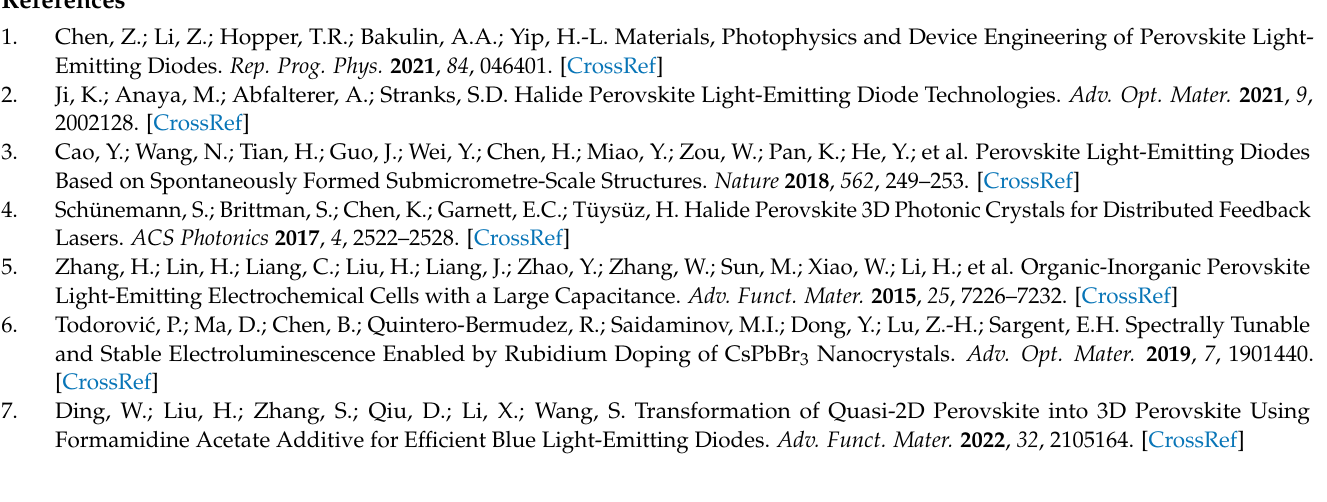
perovskite films; Table S5: Calculated formation enthalpy of PEA 2 PbBr 4 and m-FPEA 2 PbBr 4 2D